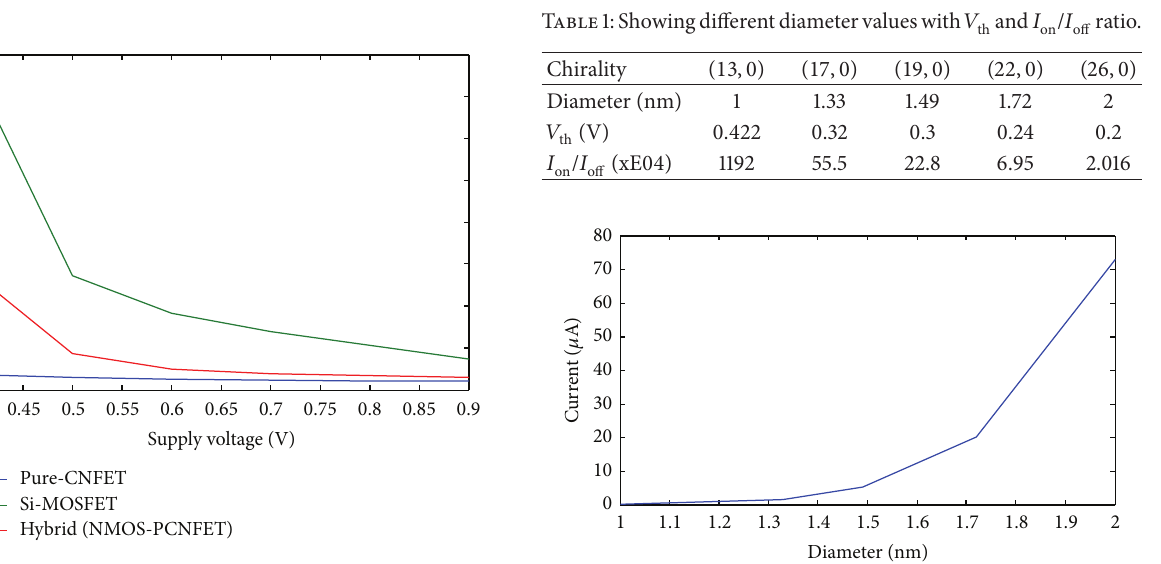
Figure 2: The propagation delay of pure-CNFET, hybrid and CMOS inverters for different supply voltages.